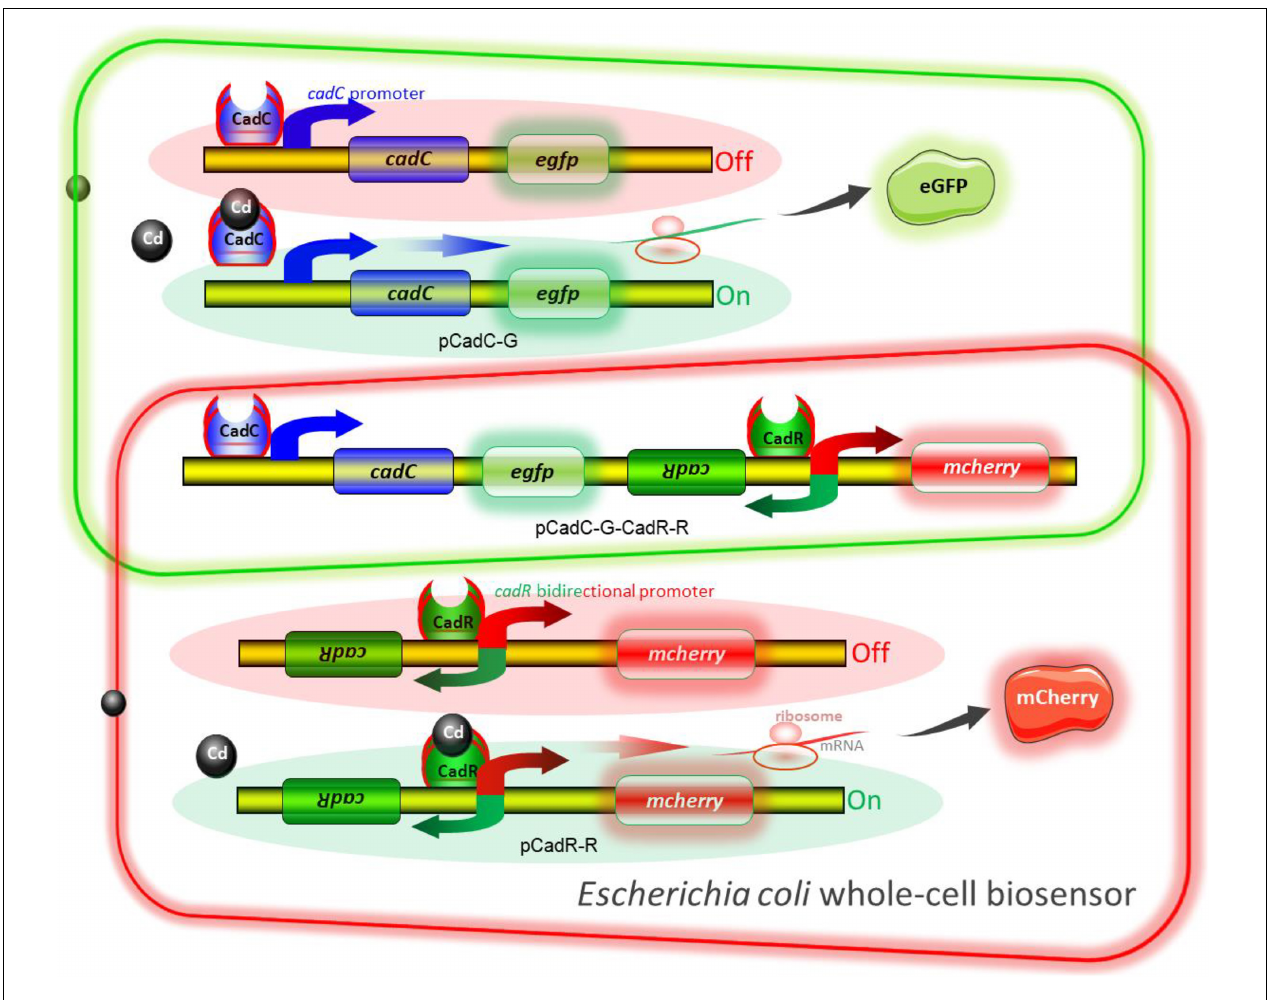
FIGURE 2 | Models for single and double fluorescent indication of cadmium exposure. The apo-form dimeric CadC bound to the cadC promoter represses transcription of the green fluorescent reporter. The binding of Cd(II) causes the conformational change of dimeric CadC, and then, it will dissociate from the cadC promoter to activate the transcription of the green fluorescent reporter (schematic in green box). The dimeric CadR acts as both a transcription repressor (with no cadmium exposure) and an activator (with intracellular cadmium exposure). When the concentration of intracellular Cd(II) increases, dimeric CadR bound to the cadR divergent promoter will activate transcription of the red fluorescent reporter (schematic in red box). With the integration of two independent sensing modules, the resultant biosensor cell can detect Cd(II) with double-color fluorescence output (overlap between the green and red boxes).